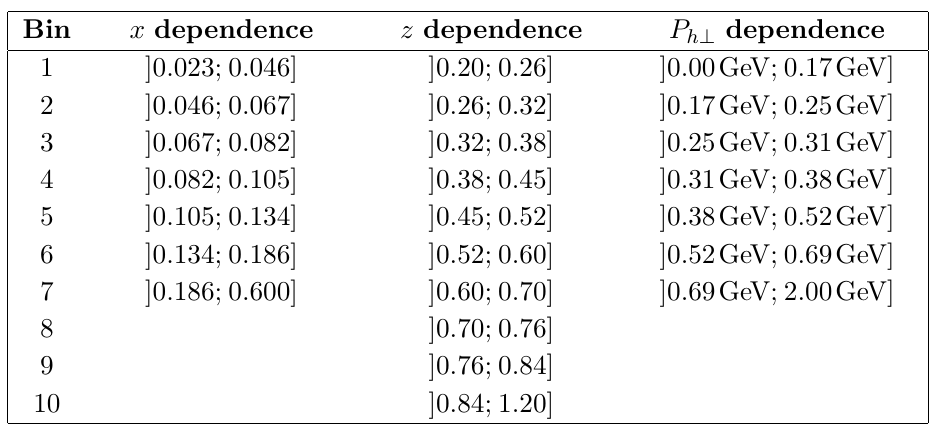
Table 7 . Definition of the one-dimensional binning for mesons: the first column lists the bin number; the second, third, and fourth columns give the corresponding limits in the kinematic variables x , z , and P h ⊥ , respectively.